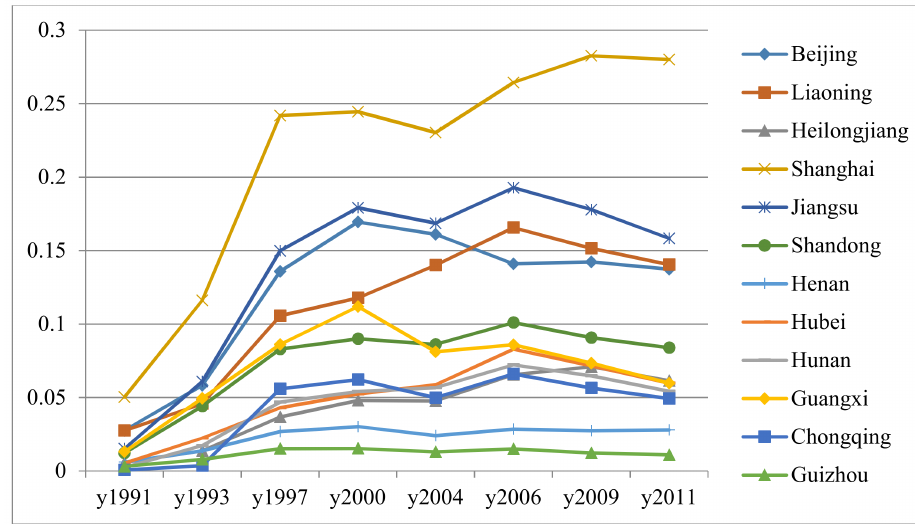
Figure 1. FDI openness statistics across sample regions and